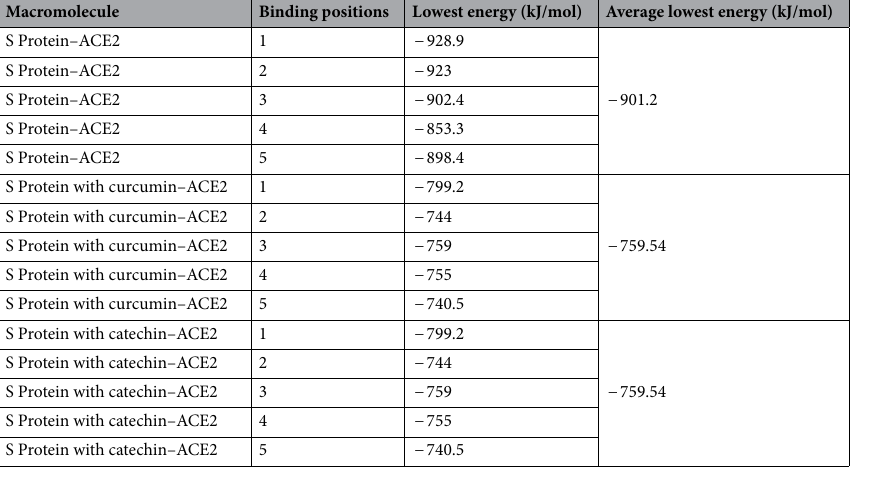
Table 1. Protein–protein interaction depicting 5 lowest binding energy for S Protein–ACE2 complex in the presence or absence of curcumin and